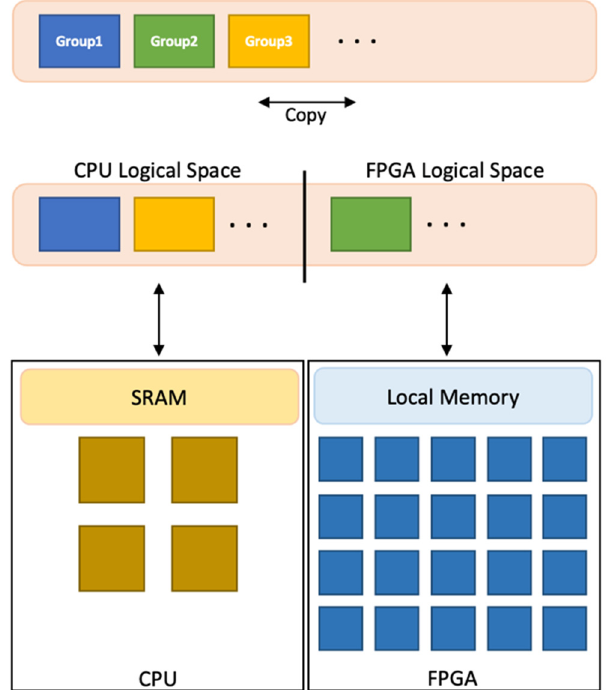
Figure 7. Dataflow by weight group.